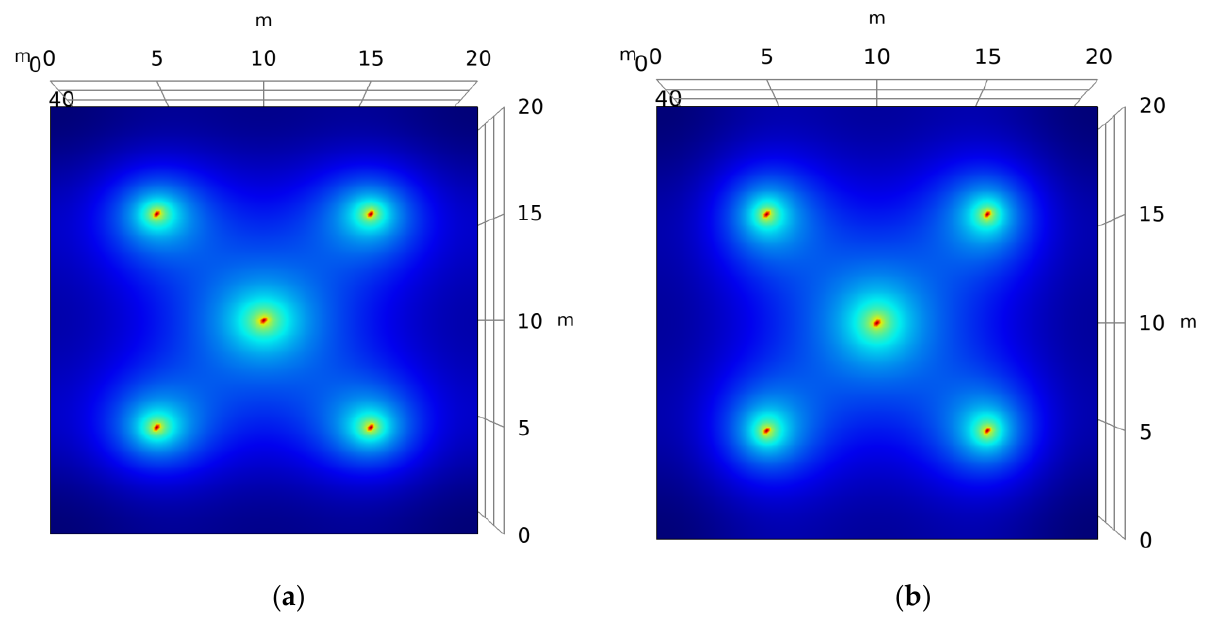
Figure 13. Temperature field distribution after heating for 1000D. ( a ) Considering anisotropy; ( b ) considering isotropy.